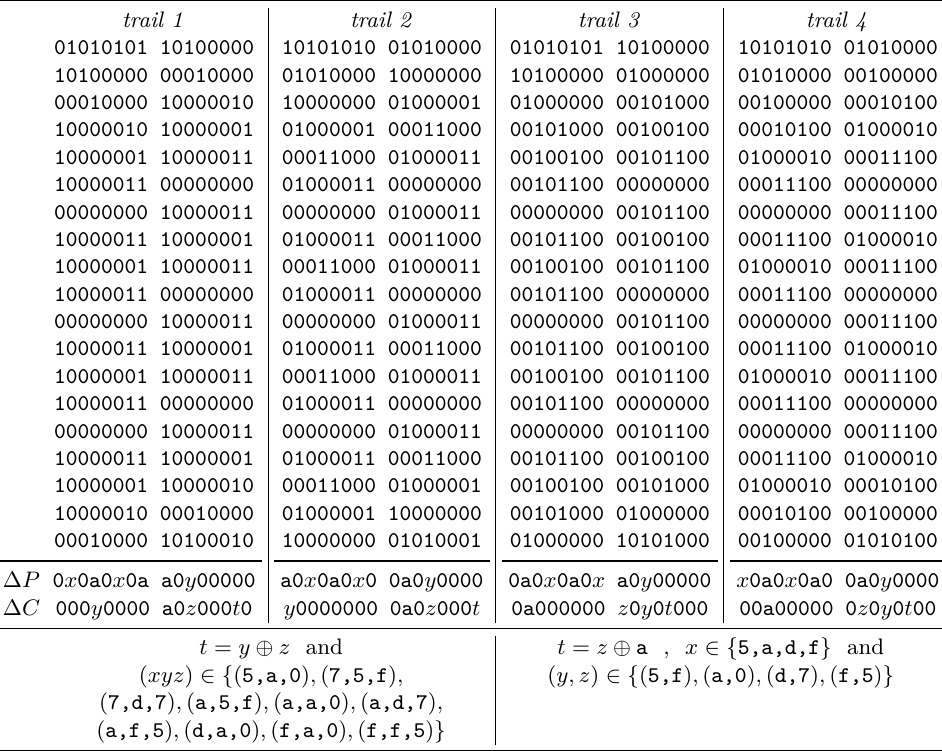
Table 2: The maximum EDP for the differentials within the activity patterns with minimum number of active S-boxes. Note we use p = − log for the EDP.